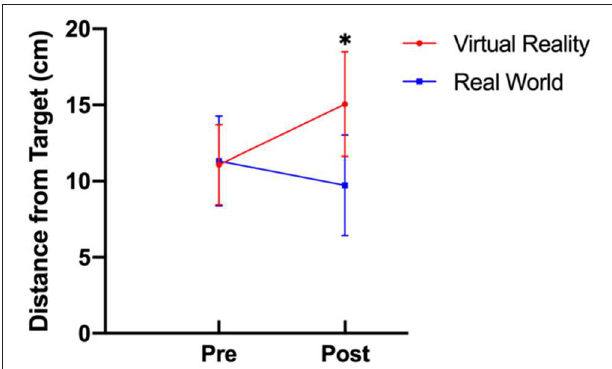
FIGURE 1 | Dart-throwing accuracy before and after training for the virtual reality and real-world training groups (* denotes p <